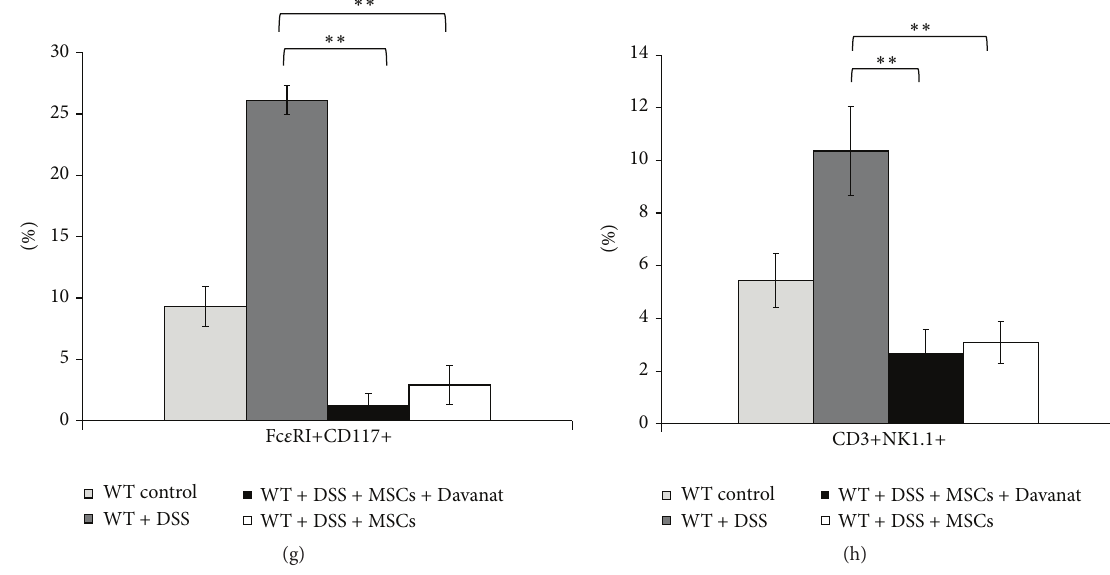
Figure 3: Pharmacological inhibition of Gal-3 in MSCs favored alternative activation of macrophages in the colon tissues of DSS-treated mice. The percentage of F4/80+ macrophages in colon tissue (a). Significant decrease in percentage of F4/80+CD206+ and F4/80+ IL-10+ macrophages in MSCs-treated mice (white bars), when compared to MSCs + Davanat-treated mice (black bars), after 7 days on DSS treatment (b and c). The percentage of IL-12- and IL-1 𝛽 -producing F4/80+ macrophages (d and e). The percentages of inflammatory dendritic cells (f) and Fc 𝜀 RI+CD117+ mast cells (g) as well as CD3+NK1.1+NKT cells (h) are shown. Values are mean ± SEM ( 𝑛 = 10 per group). ∗ 𝑃 < 0.05 , ∗∗ 𝑃 < 0.01